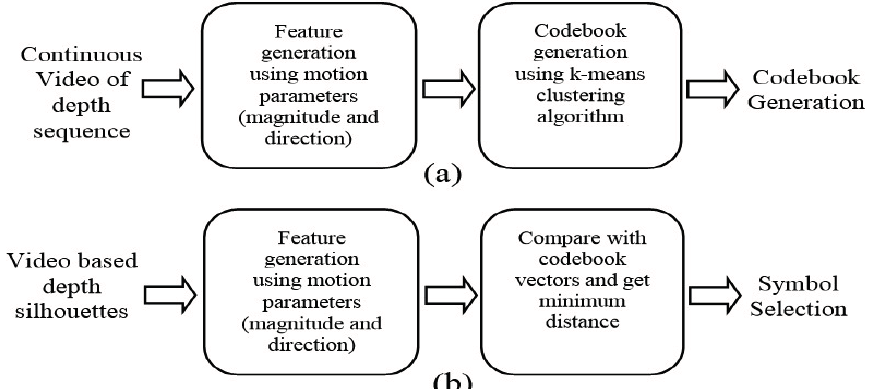
Figure 7. Basic steps of ( a ) codebook generation and ( b ) code selection for